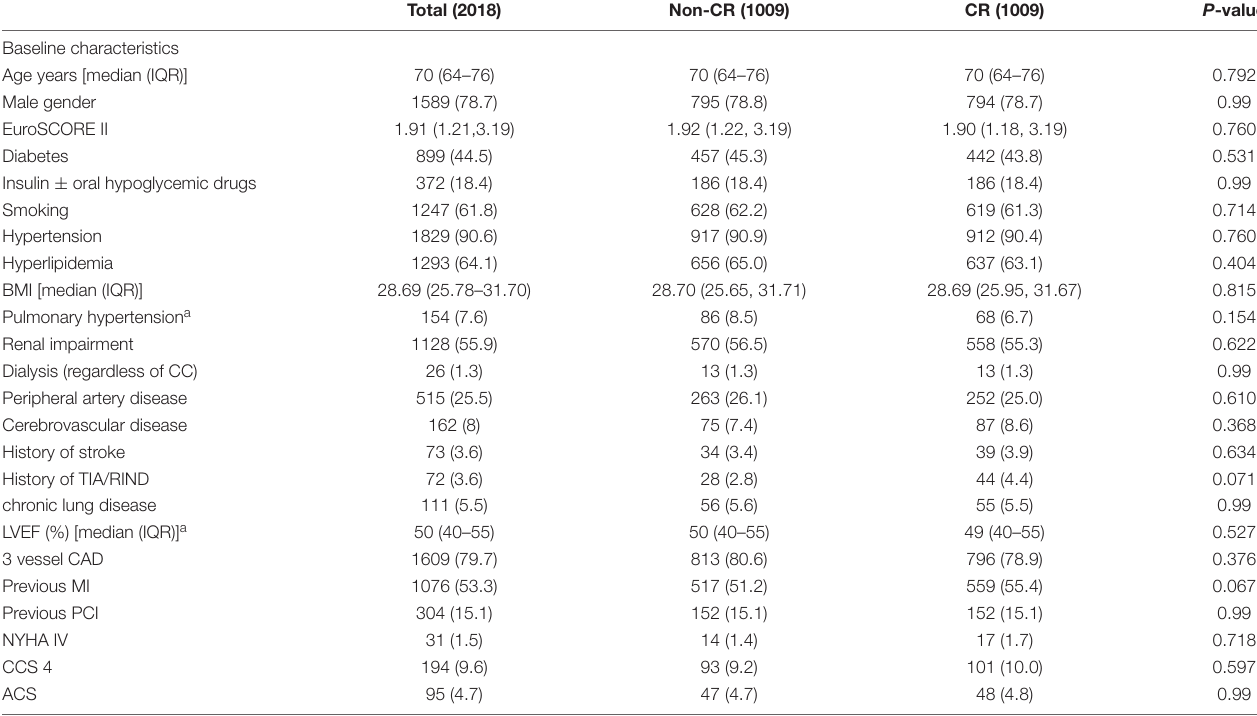
TABLE 1 | Pre-operative characteristics after